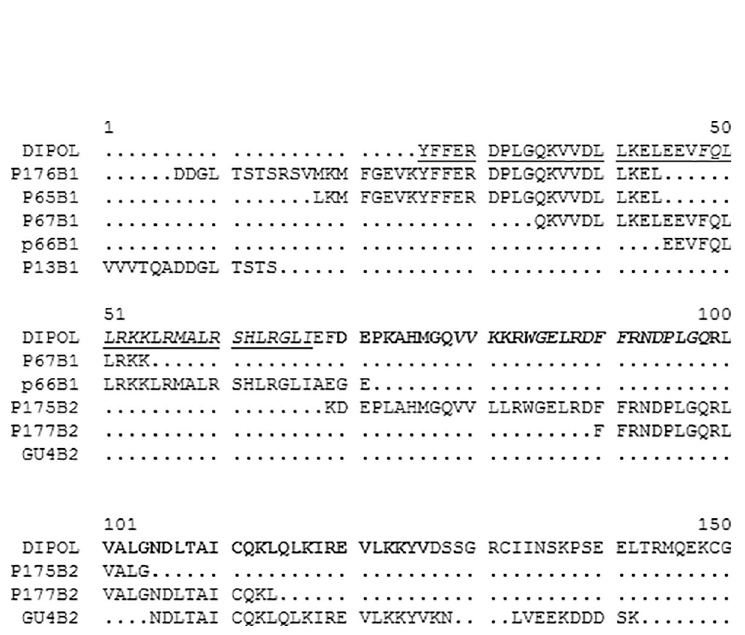
Fig 3. Alignment of the epitopes described by several authors (p65 [35], 1994; p66, p67, p175 and p177 [36]; p13 [37], and GU4 [38]) for the antigens B1 and B2, and the DIPOL sequence corresponding to the abovementioned antigens. The name for each epitope and its antigen of origin are shown in the figure.